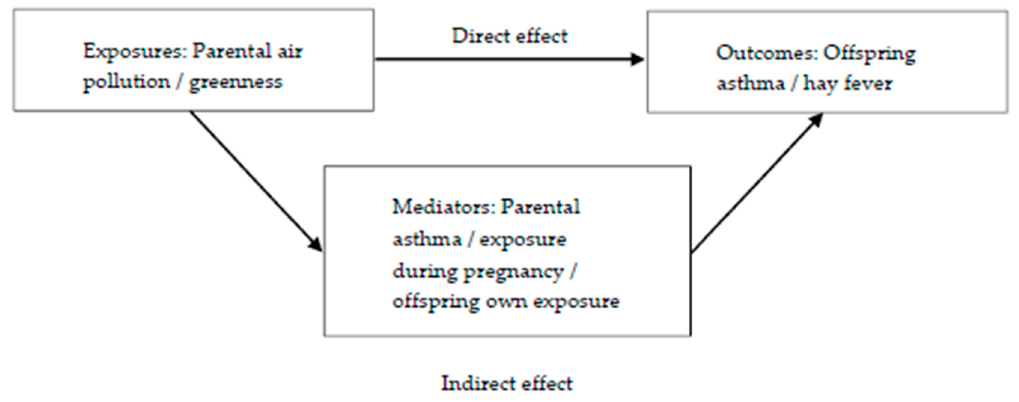
Figure 2. Mediation models for the effects of parental exposures (air pollution/greenness) on offspring’s outcomes (asthma or hay fever).